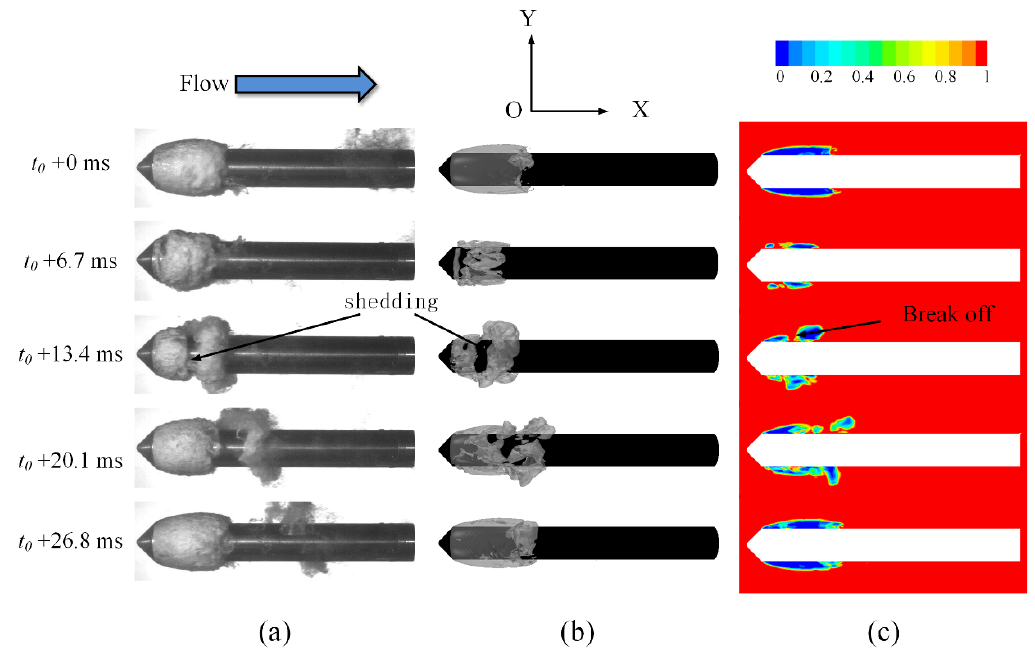
Figure 5. Comparison of natural cavity evolution: ( a ) experimental observation; ( b ) numerical simulation; ( c ) prediction of XOY surface water volume fraction. (The value of water volume fraction is 0–1.)